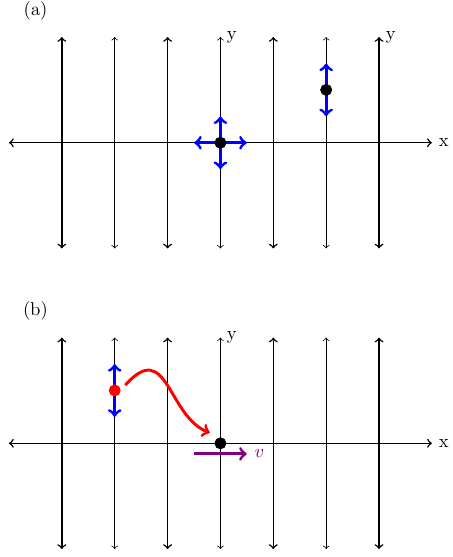
Figure 1. The different situation to walkers that moves on comb structure. Figure ( a ) shows two walkers, one on x -axis ( y = 0) that admits the next step in both directions, the other walker out of the = 0) can move only in y -axis to anyone y x axis ( y − (cid:54) structure that is resetting to position x resetting = vt on black